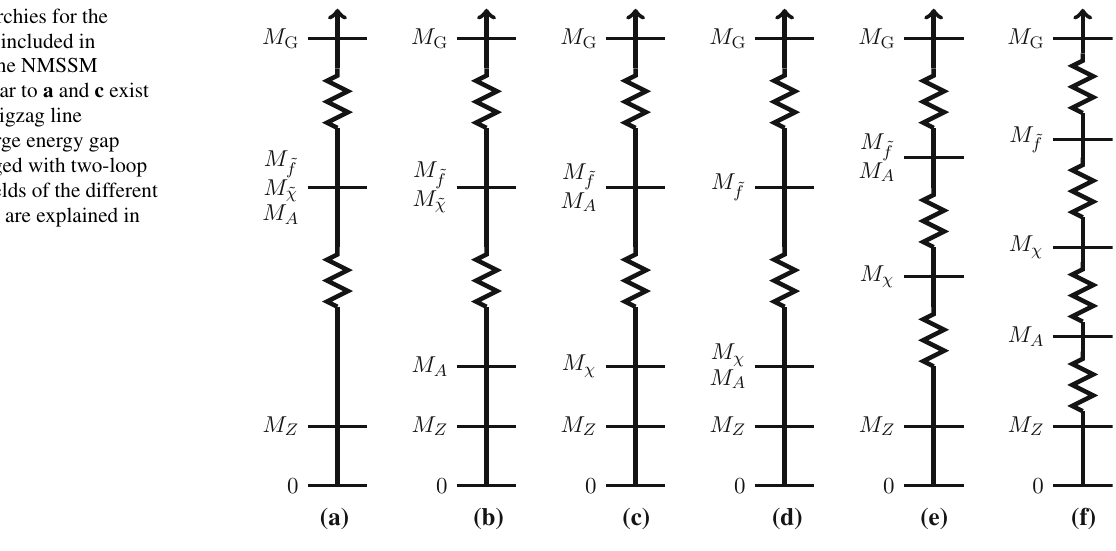
Fig. 7 Hierarchies for the MSSM so far included in SARAH . For the NMSSM versions similar to a and c exist as well. The zigzag line represent a large energy gap which is bridged with two-loop RGEs. The fields of the different mass symbols are explained in Sect. 4